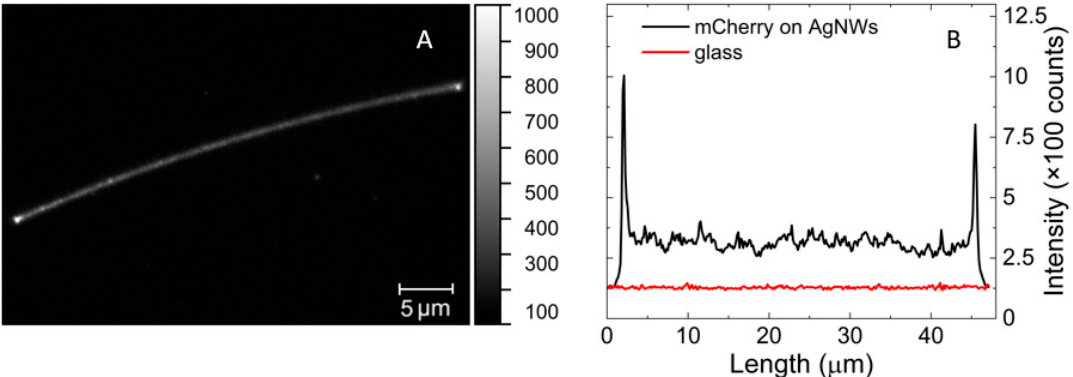
Figure 4. Fluorescence intensity maps of mCherry conjugate with AgNWs (on the left ( A )) and cross-section along the silver nanowire and on glass (on the right ( B )).